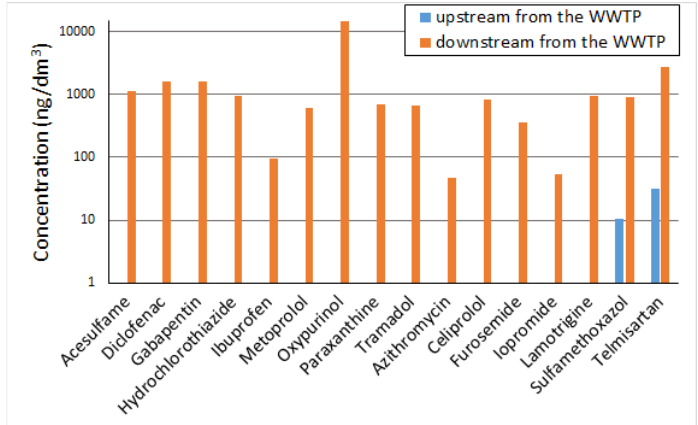
Figure 11. Concentration of 16 selected pharmaceuticals in profiles above and below Hnevkovice WWTP on 21 October 2019 (only substances detected above the detection limit).